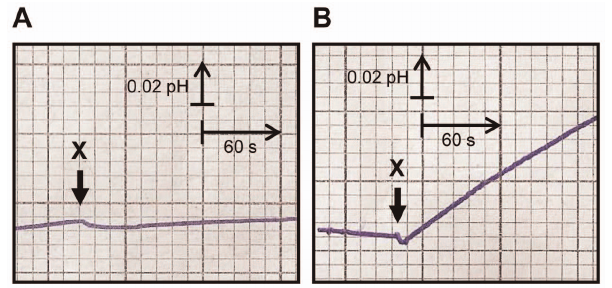
Figure 1. Symport activity in D. hansenii CBS 767 with and without starvation. Effect on extracellular pH elicited by addition of 10 mM D-xylitol to unbuffered cell suspensions (pH 5, 1 M KCl) of D. hansenii CBS 767, grown on YNB medium with 2% xylitol, without starvation (A) and after 3 h starvation (B). The arrows indicate the times of xylitol addition. Data are representative of at least two independent experiments.